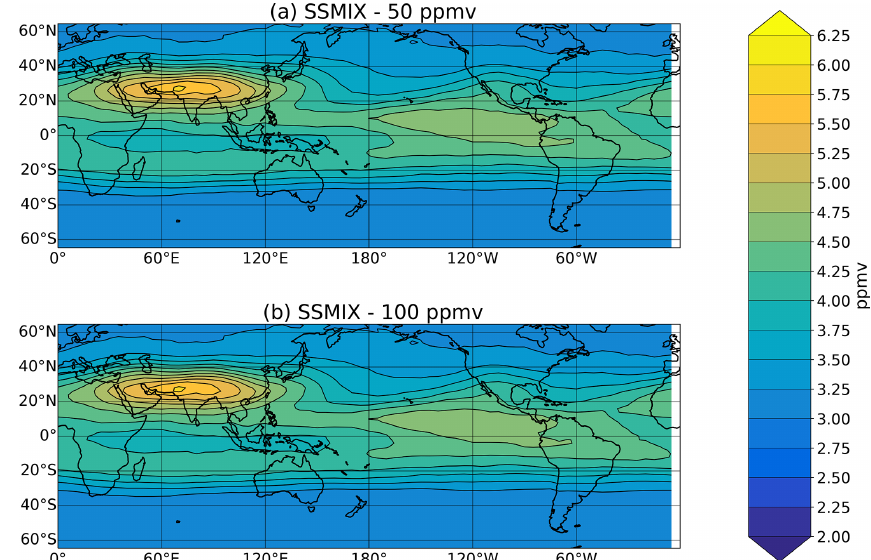
Figure A3. Distribution of water vapour at 100hPa of SSMIX initialized with (a) 50ppmv and (b) 100ppmv during boreal summer for